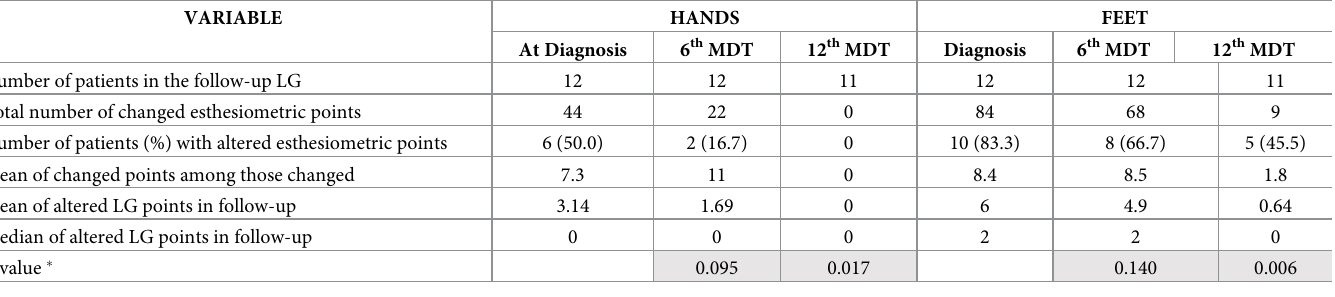
Table 6. Evolution of the number of altered sensitivity points on the hands and feet tested at diagnosis, in the 6 th month and after the 12 th month of multidrug ther- apy of the leprosy patients from the Female Penitentiary of Ribeir ã o Preto. VARIABLE